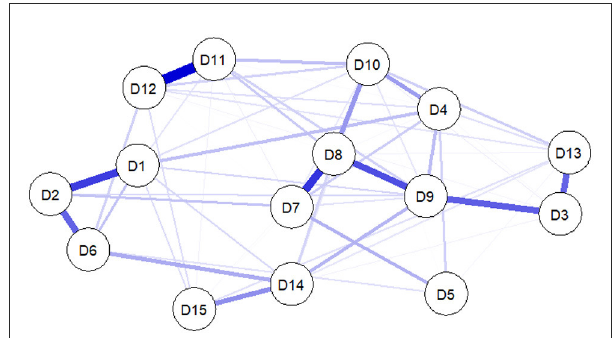
FIGURE1 Estimated network plot for symptoms in the total sample. The network model was estimated using the GGM model. D1, back pain; D2, pain in arms, legs, or joints; D3, menstrual cramps or other problems with periods; D4, headaches; D5, fainting spells; D6, pain or problems during sexual intercourse; D7, chest pain; D8, shortness of breath; D9, feeling heart pounding or racing; D10, dizziness; D11, feeling tired or having low energy; D12, trouble sleeping; D13, stomach pain; D14, nausea, gas, or indigestion; D15, constipation, loose bowels, or diarrhea.